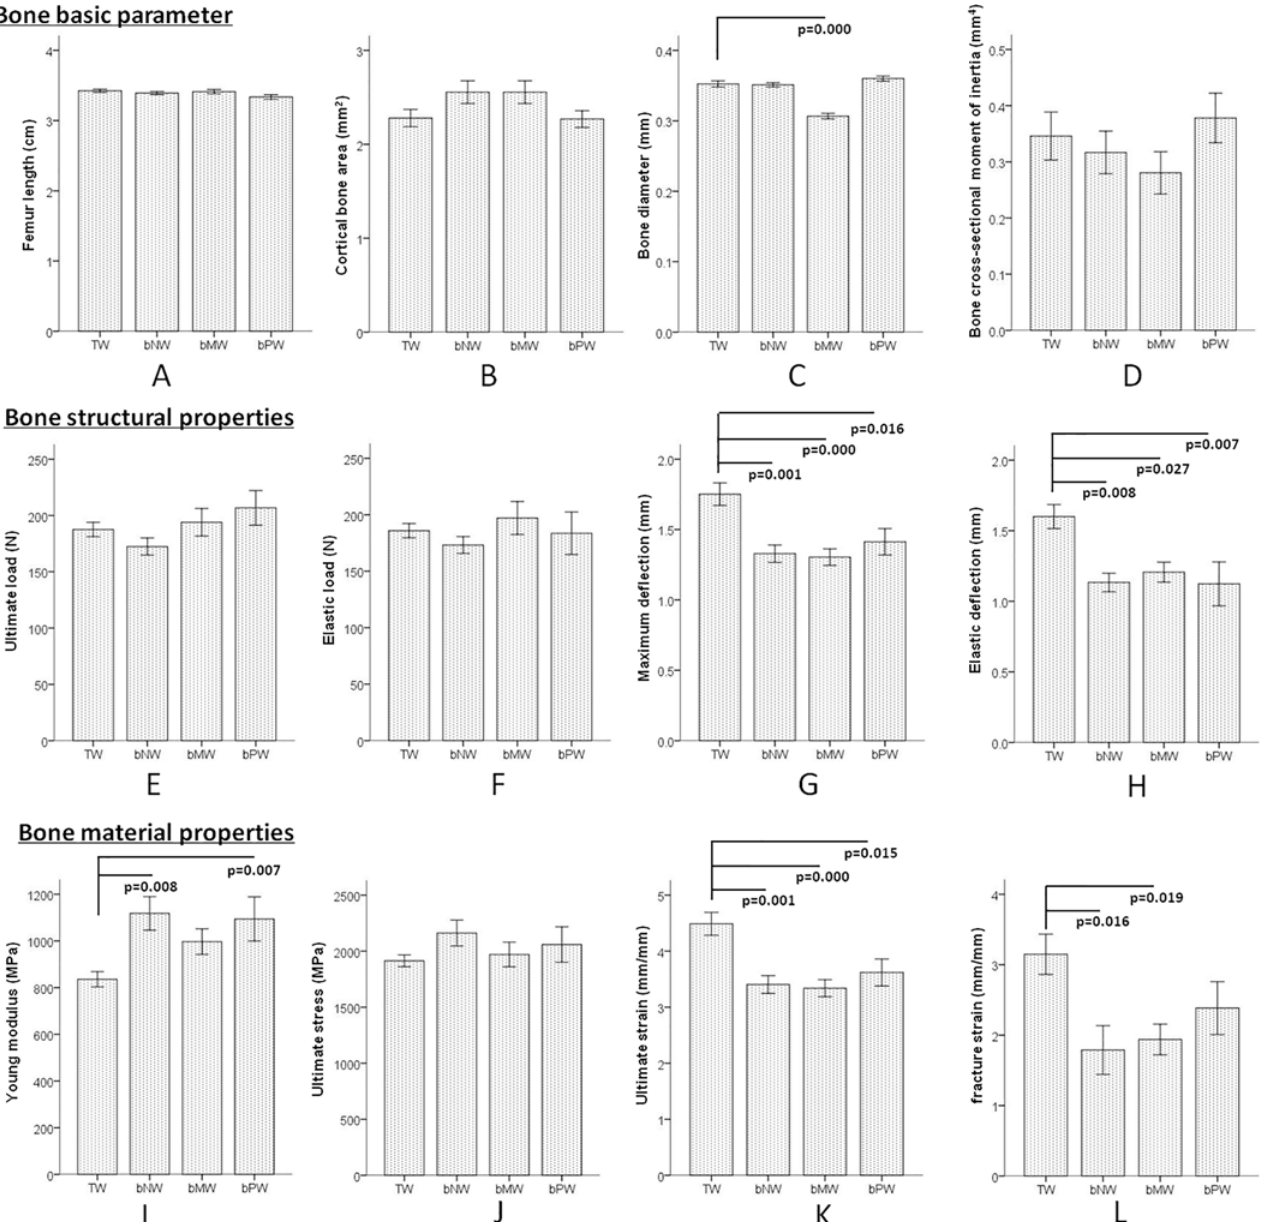
Fig 1. Femur biomechanical properties, according to the three-point bending test, of F2 female rats after three generations of continuous drinking of four water types. The basic bone parameters, including length, cortical bone area, bone diameter and bone cross-sectional moment of inertia, are shown in A, B, C, and D, respectively; the bone structural properties, including ultimate load, elastic load, maximum deflection of femoral diaphysis and elastic deflection, are shown in E, F, G, H, respectively; the bone material properties, including Young modulus, ultimate stress, ultimate strain and fracture strain, are shown in I, J, K, L, respectively. TW: Tap water, bNW: bottled natural water, bMW: bottled mineralized water, bPW: bottled purified